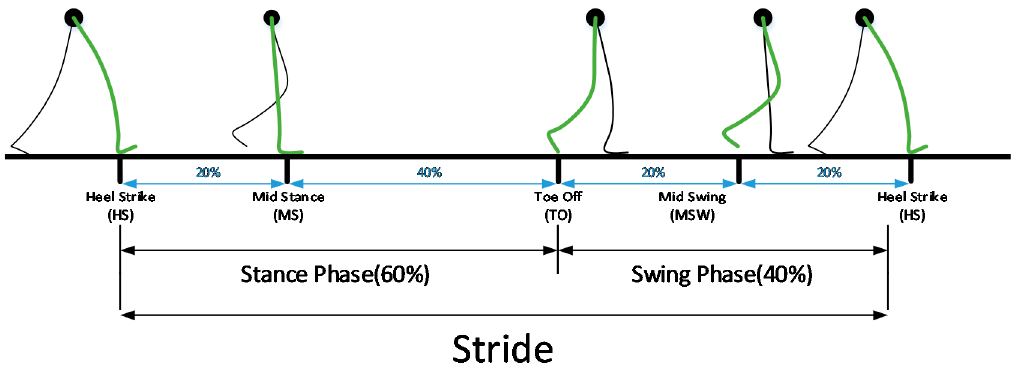
Figure 1. The stride (gait cycle) is divided into the stance phase and the swing